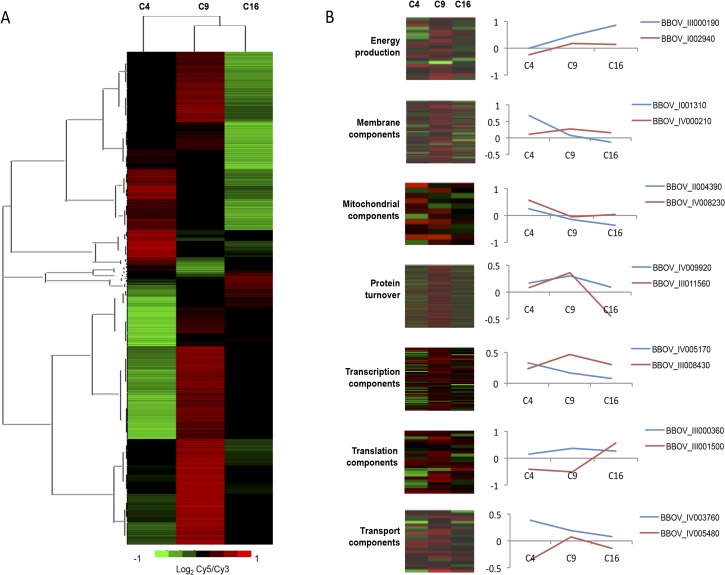
Biological processes involved in B. divergens parasites’ intra-erythrocytic development.Transcripts from adapted cultures at 4, 9 and 16 hours were analyzed based on their M-values (log2 Cy5/Cy3) and visually inspected to identify an alternative parasitic expression pattern (A). Transcripts were clustered based on their shared expression profiles in the 4-hour culture (C4). Functional classification was performed based on GO-cellular compartment, molecular function and biological process domains (B).